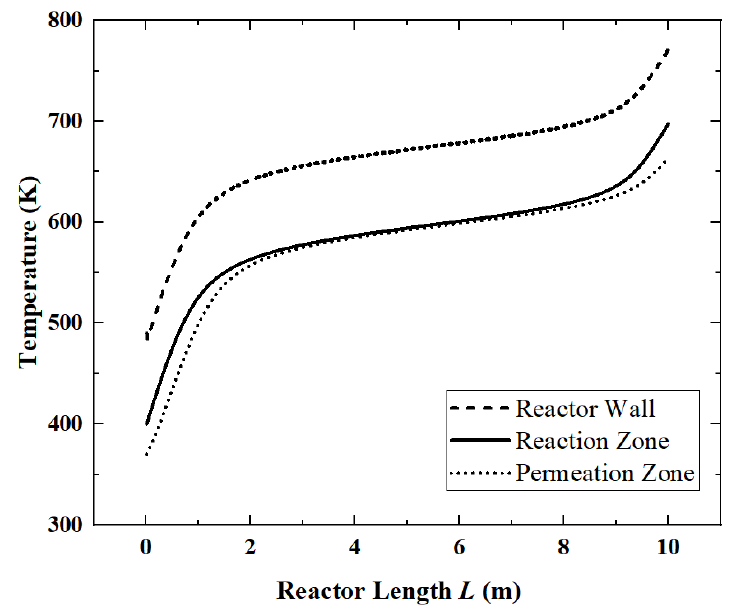
Figure 4. Temperature changes along the reactor length.